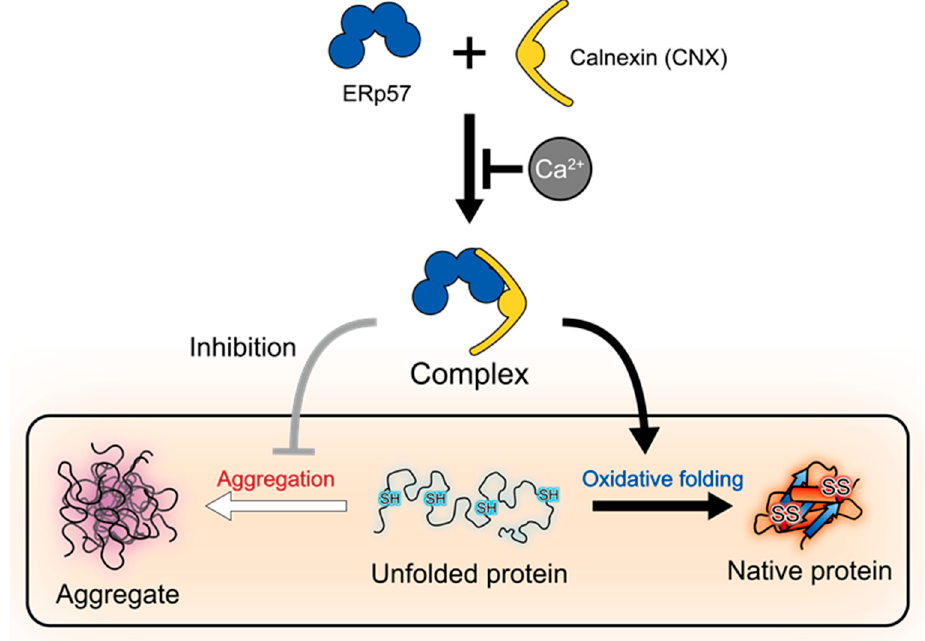
Figure 5. Proposed model of Ca 2+ -regulated ERp57-CNX complex formation promoting productive client folding.